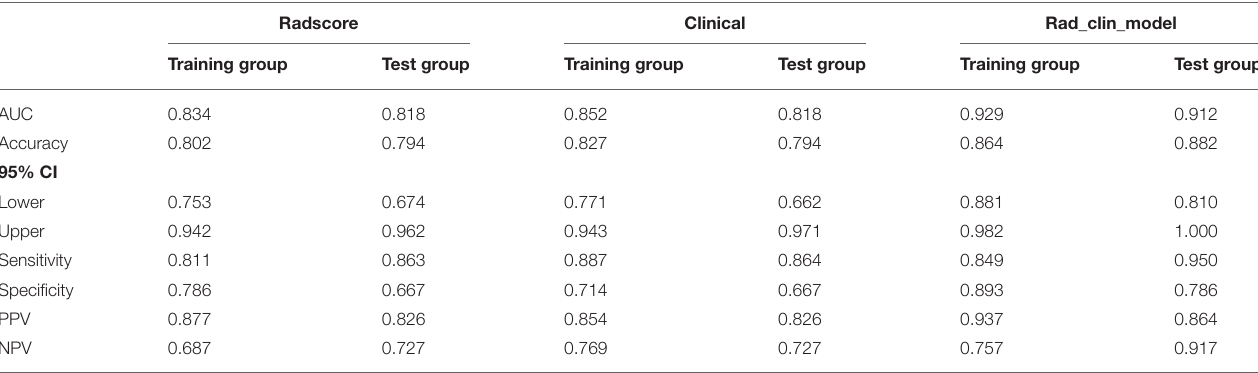
TABLE 3 | Diagnostic performance of the Radscore, clinical model, and